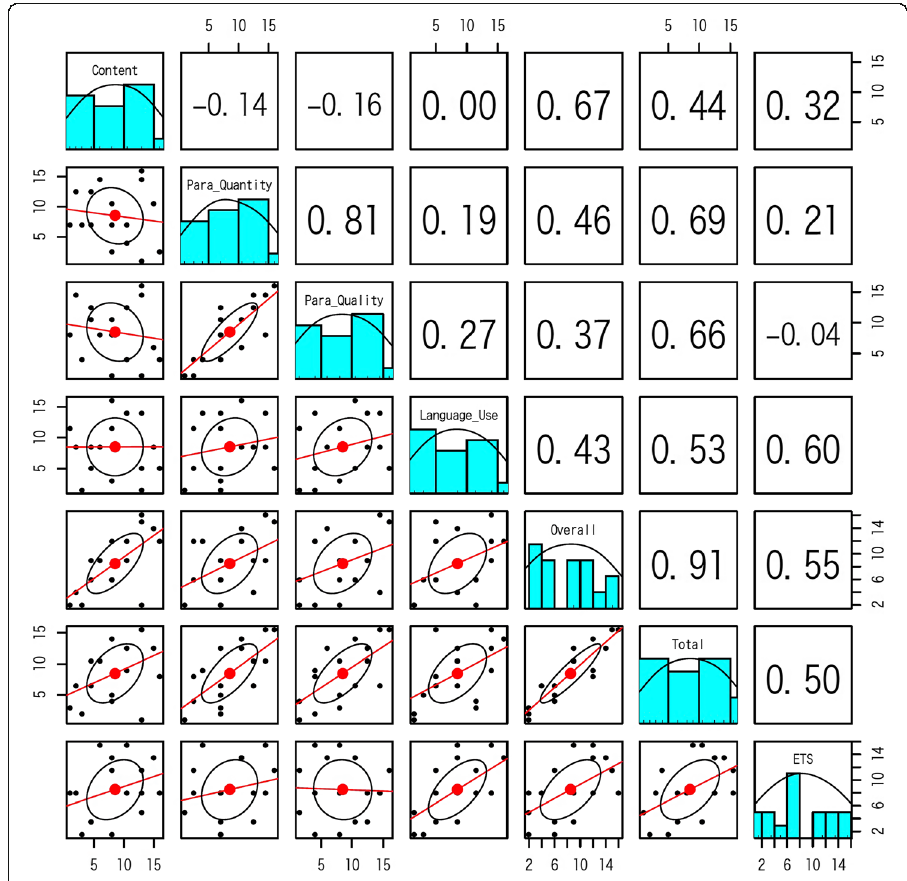
Fig. 2 Correlation matrix and histogram. Scatter plots are shown in the lower left triangle, correlation coefficients are shown in the upper right triangle, and the remainder are